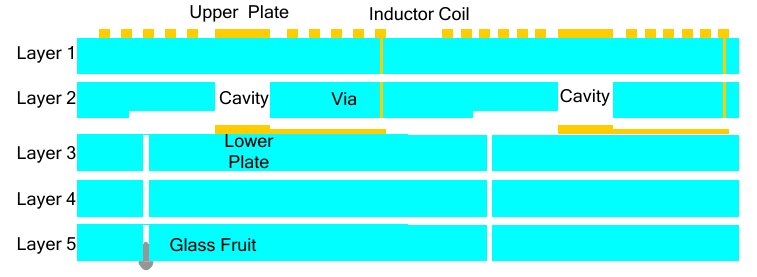
Figure 9. Temperature compensation structure for complex